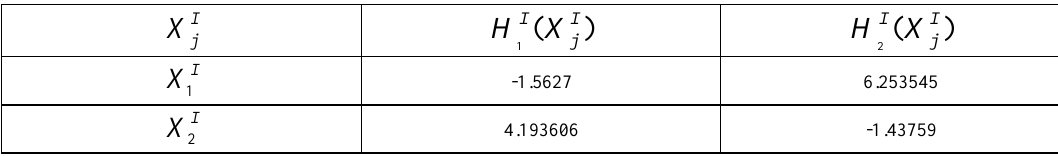
Table 2. Pay-off table at initial solutions of first